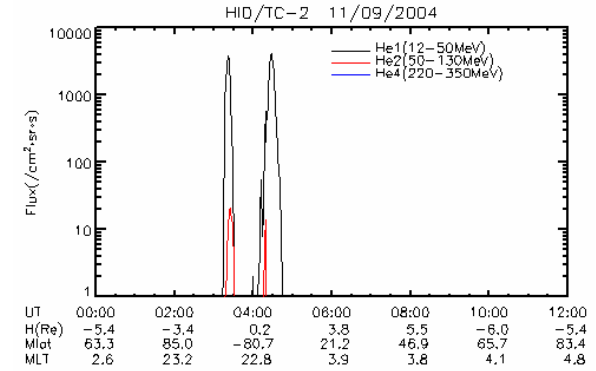
Fig. 18. The minute-averaged helium ion flux in energy channels He1, He2 and He4 observed by HID on 14 September 2004 (after CME